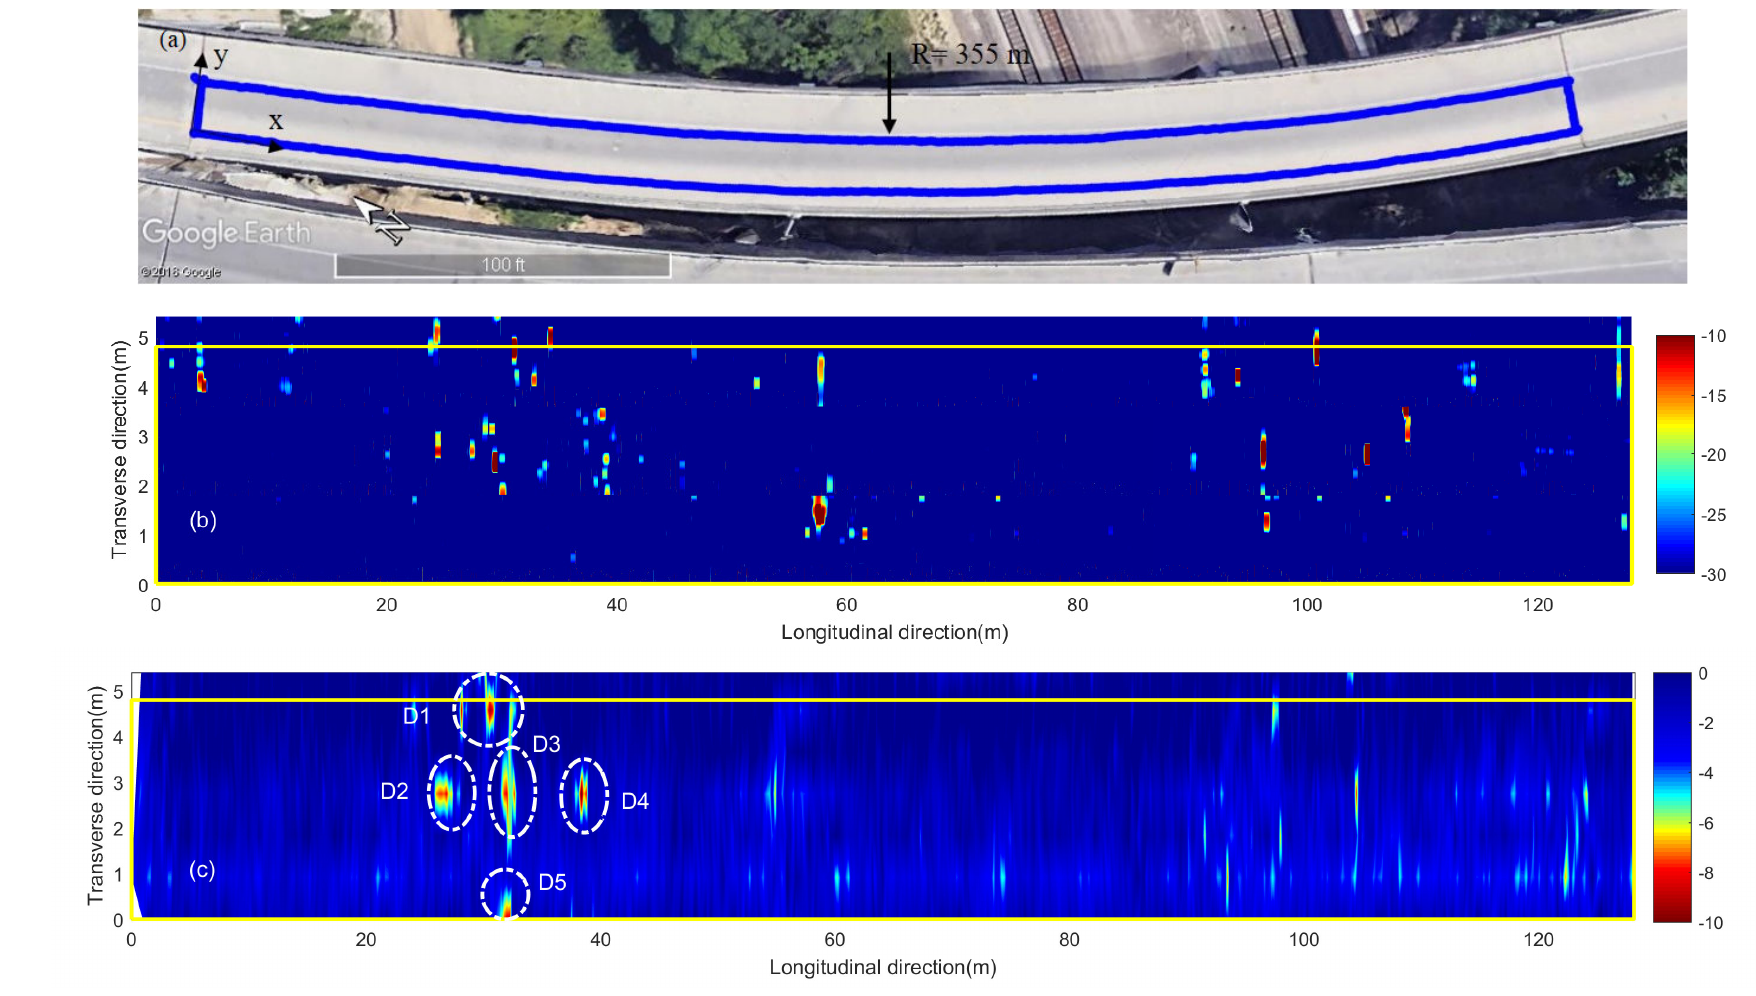
Figure 12. Curved concrete bridge deck: ( a ) Google Earth image; ( b ) acoustic scanning image; ( c ) GPR attenuation